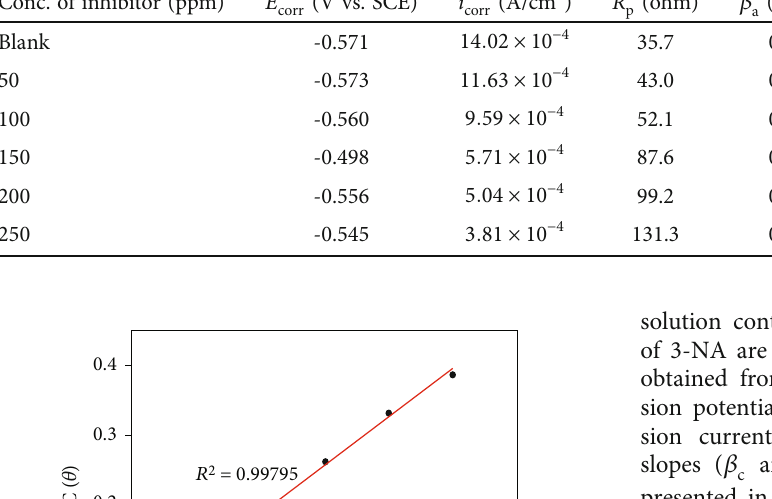
Table 4: The polarization parameters for mild steel in 1 N HCl in the presence and absence of 250ppm of 3-nitroacetophenone. Conc. of inhibitor (ppm) E corr (V vs. SCE)